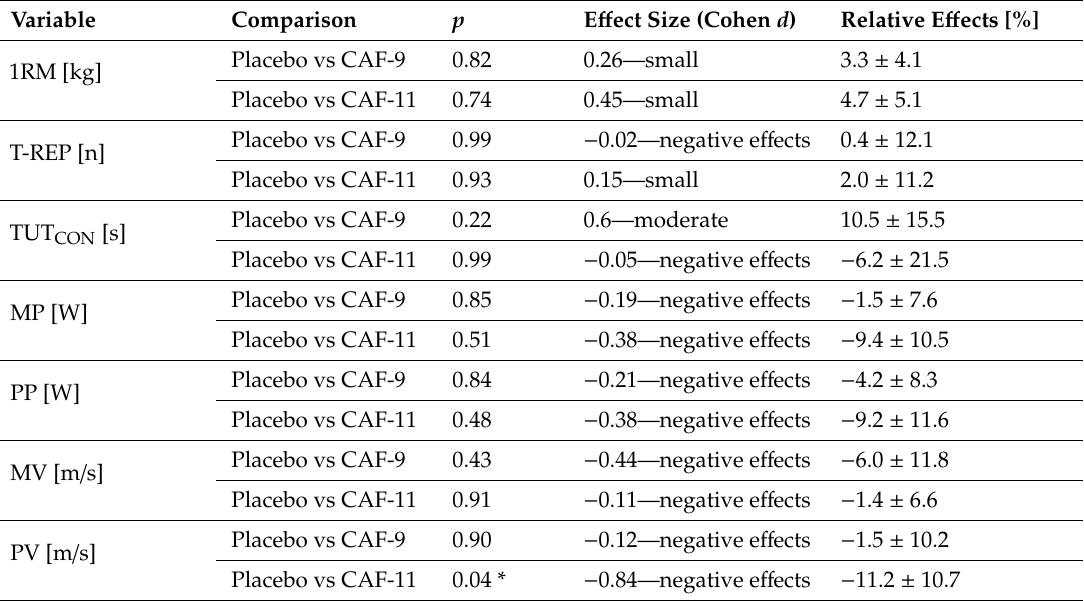
Table 2. Di ff erences in placebo vs. ca ff eine conditions between experimental